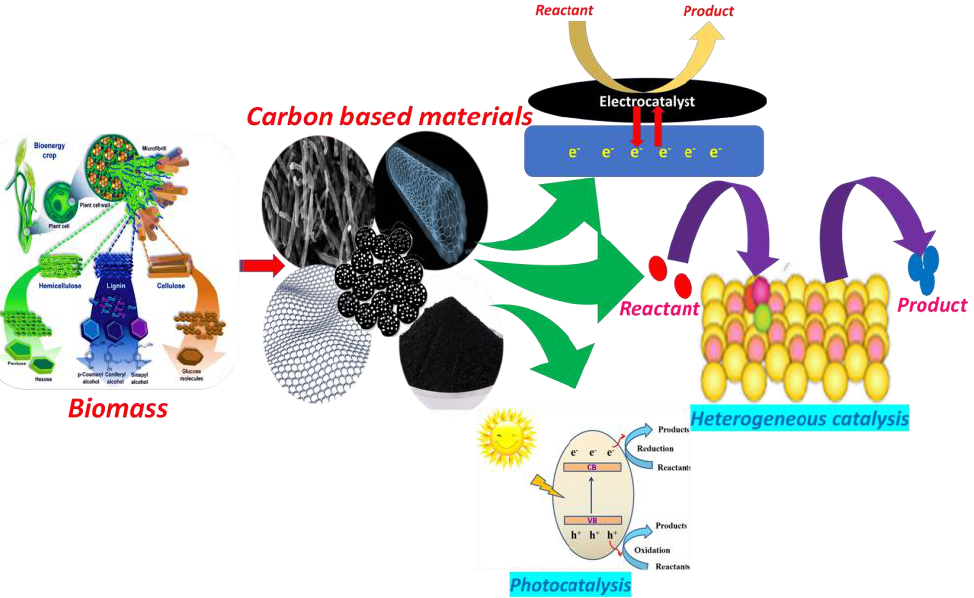
Figure 1. Graphical illustration of various biomass-derived materials in heterogeneous catalysis [12,13].